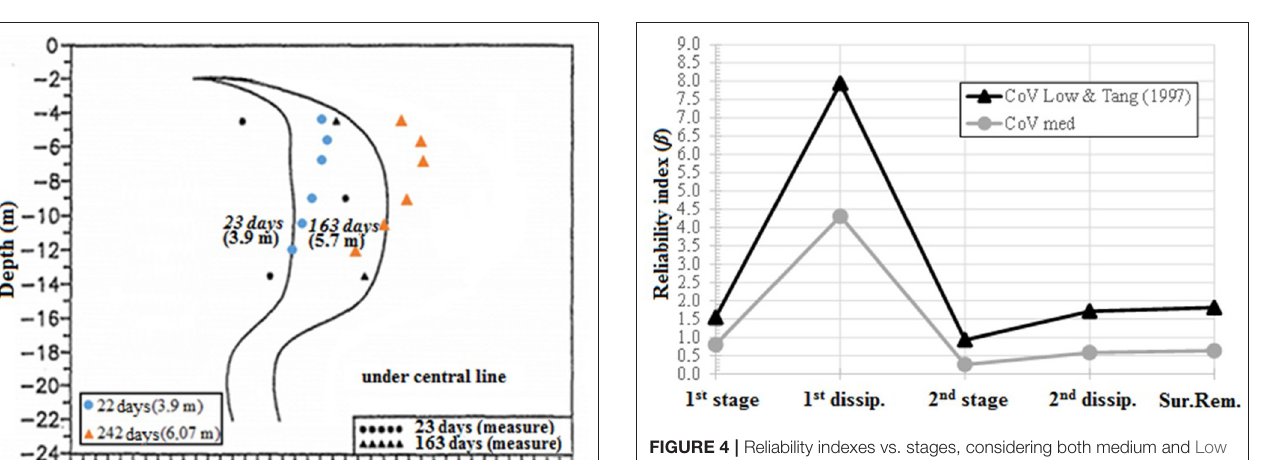
FIGURE 4 | Reliability indexes vs. stages, considering both medium and Low and Tang (1997) CoV levels (SIGMA/W + SLOPE/W).